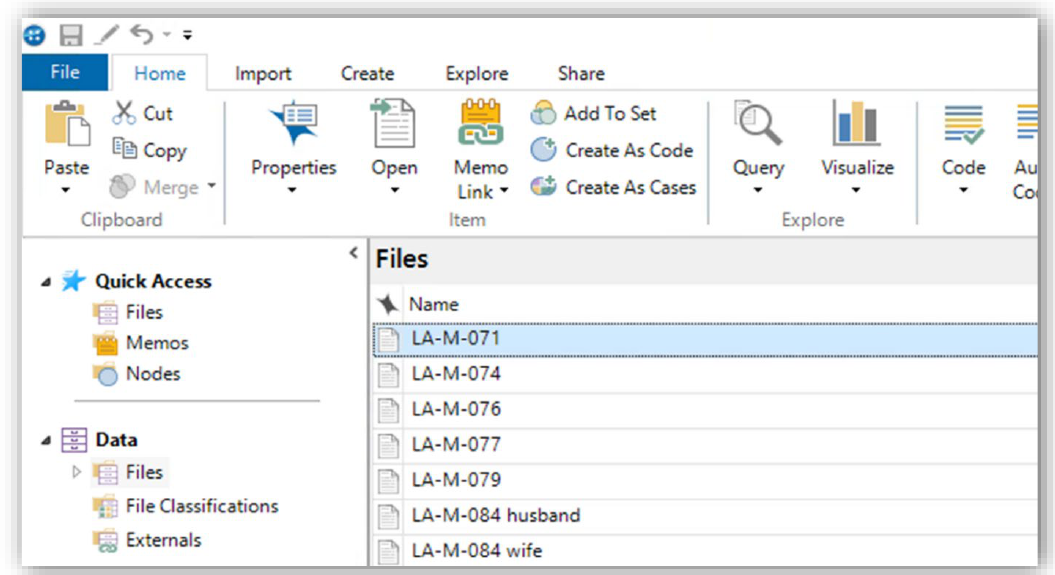
Figure 1. Open coding with the entire interview method screenshot 1 (Steps 1–3).